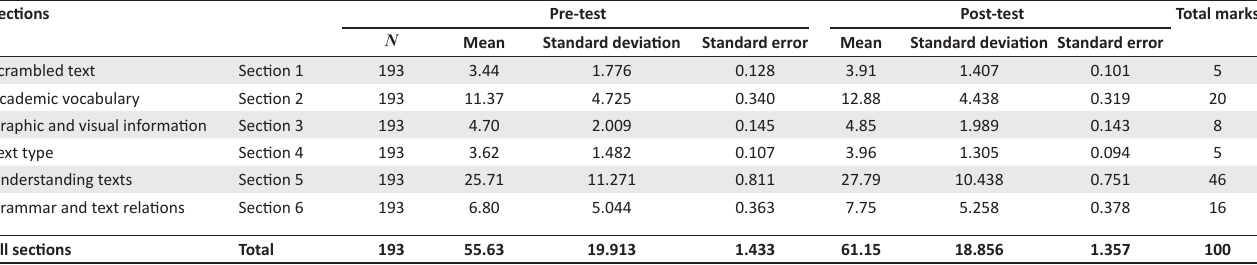
TABLE 1: Pre-test and post-test descriptive